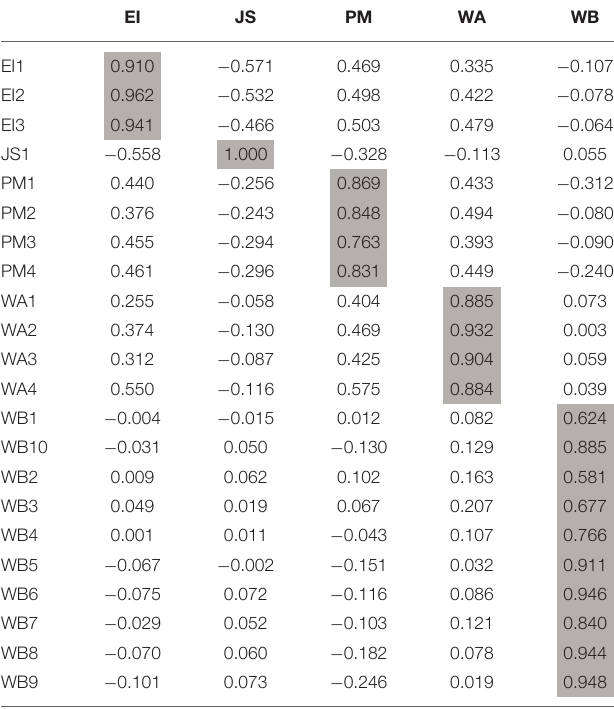
TABLE 6 | Standardized factor loadings and cross loadings of the outer